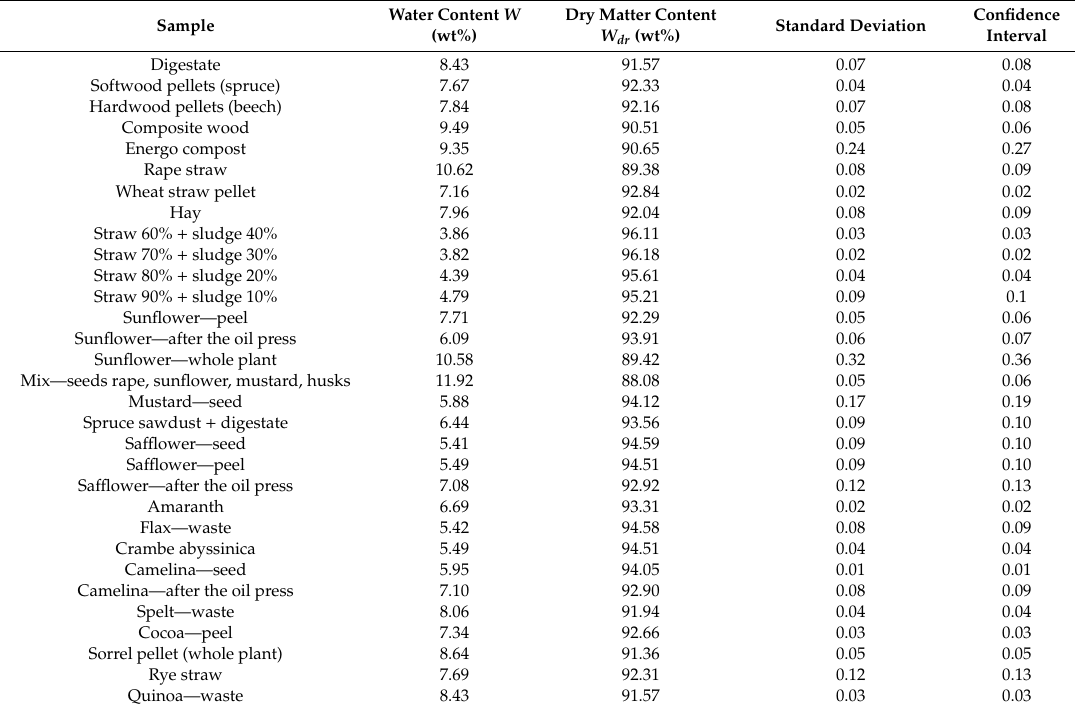
Table 1. Results of the determination of water and dry matter contents in samples of